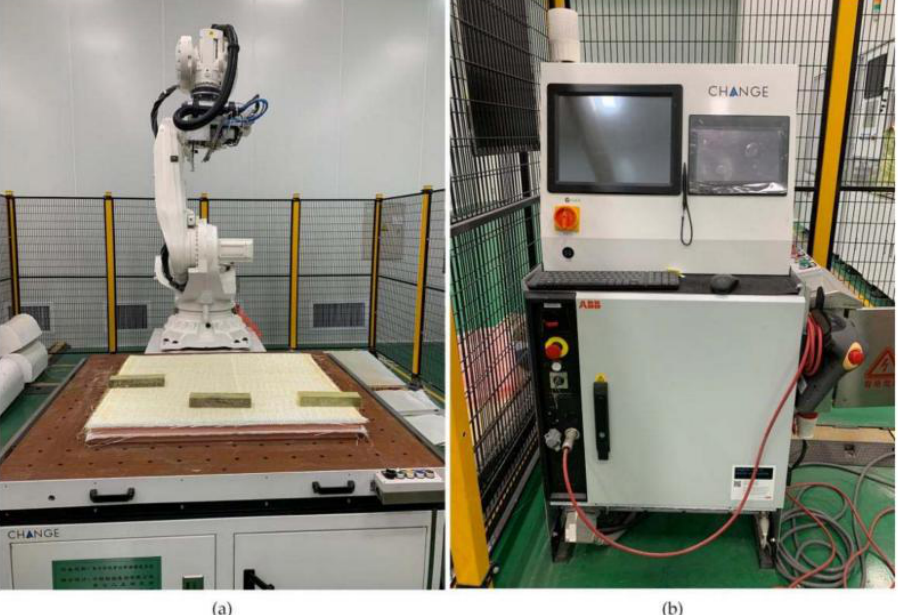
Figure 1. Suture equipment. ( a ) Opening and reinforcing seam laying equipment. ( b ) Console.